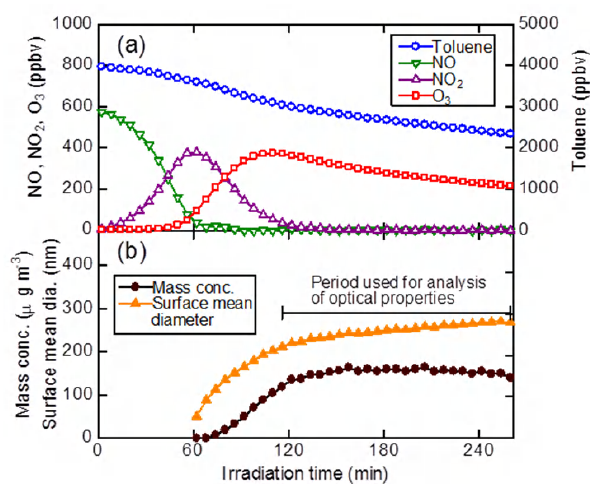
Figure 2. Temporal profiles of (a) toluene (open circles), NO (open inverted triangles), NO 2 (open triangles), and O 3 (open squares), and (b) mass concentrations (filled circles) and surface mean diameters (filled triangles) during “run A4”. The bar indicates the period used for analysis of the optical properties.